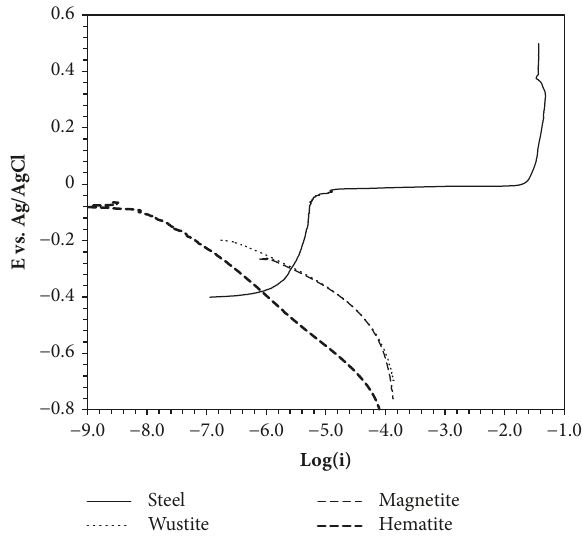
Figure 9: Cathodic curve for the iron oxides and an anodic curve for the steel